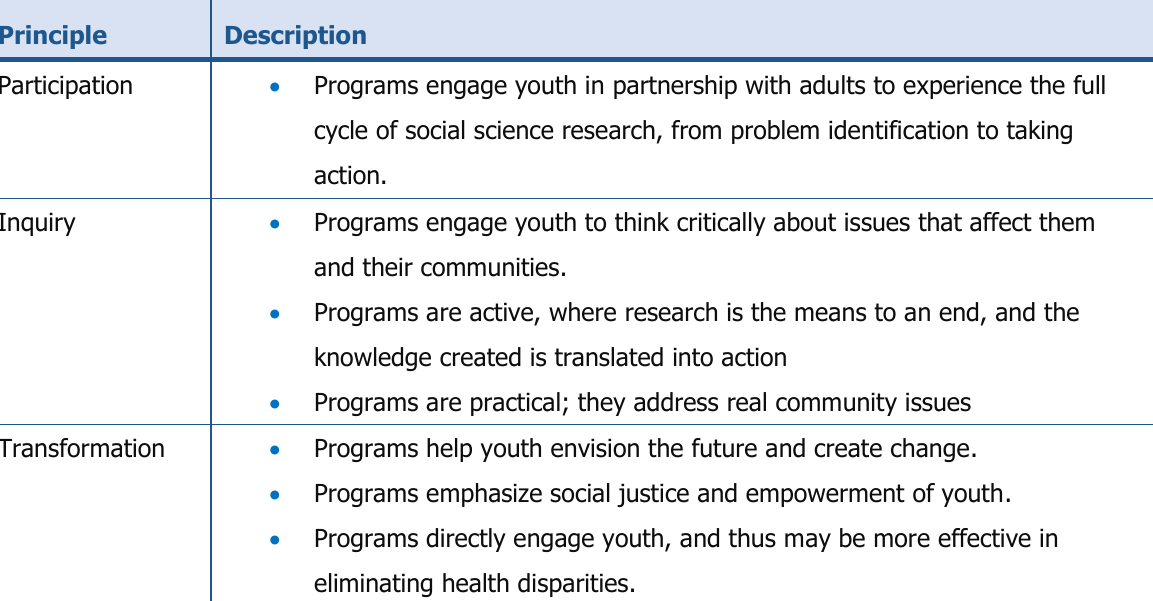
Table 1. Key Principles Guiding the Youth Participatory Action Research Curriculum (Anyon, Bender, Kennedy, & Dechants, 2018; Arnold & Gifford,